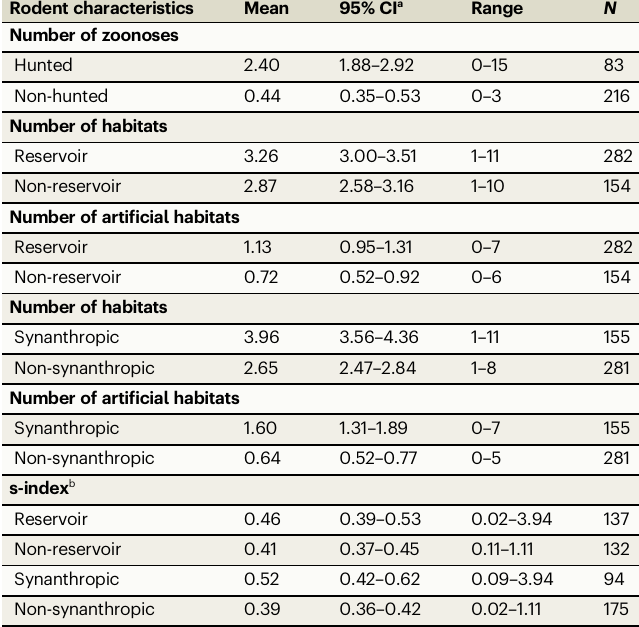
a Con fi dence interval. b Index of population fl uctuations